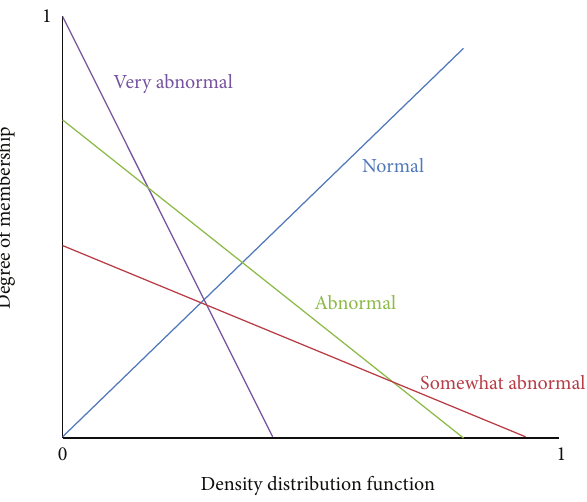
Figure 2: Membership function of the various comments.